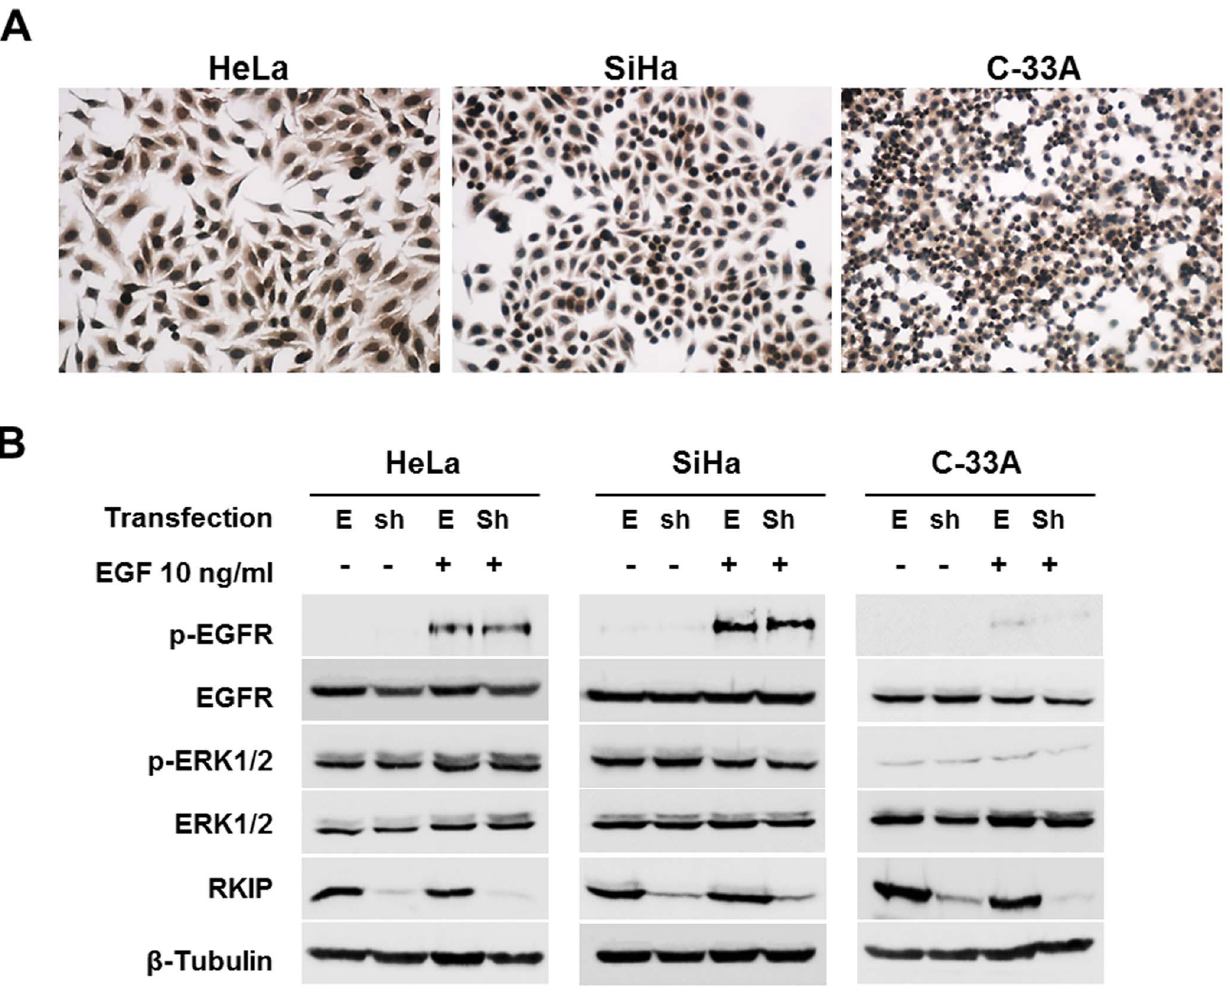
Figure 2. Effect of RKIP on ERK pathway activation in HeLa cells. A) Immunocytochemistry analysis for RKIP in HeLa, SiHa and C-33A cells showing both nuclear and cytoplasmatic expression. B) For RKIP inhibition, the cell lines were stably transfected with a shRNA for RKIP and with the respective empty vector for control. RKIP expression levels were assessed by western blot. Further, the cells were stimulated with 10 ng/ml of EGF by 10 minutes and EGFR and ERK activation (phosphorylation) was assessed by western blot for phospho-ERK1/2 and phospho-EGFR expression, but no significant differences were observed. E: Empty vector; Sh: ShRKIP.